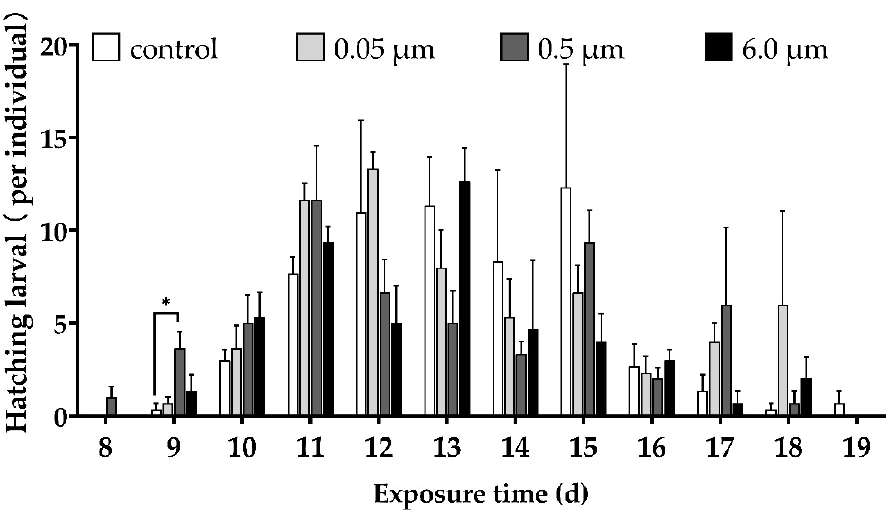
Figure A2. Effects of PS-MPs of different sizes on the numbers of hatched embryos of the O. melastigma at 3, 6 and 9 dpf (n = 100, 100 embryos for each replicate, three replicate). Asterisk indicates significant difference between the treatment group and the control (* p < 0.05).